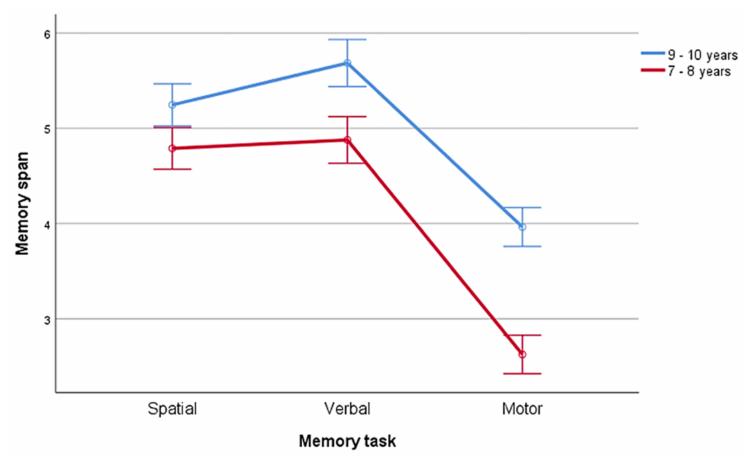
Figure 2. Memory spans are reported according to the three memory tasks and ages. Bars represent standard errors.